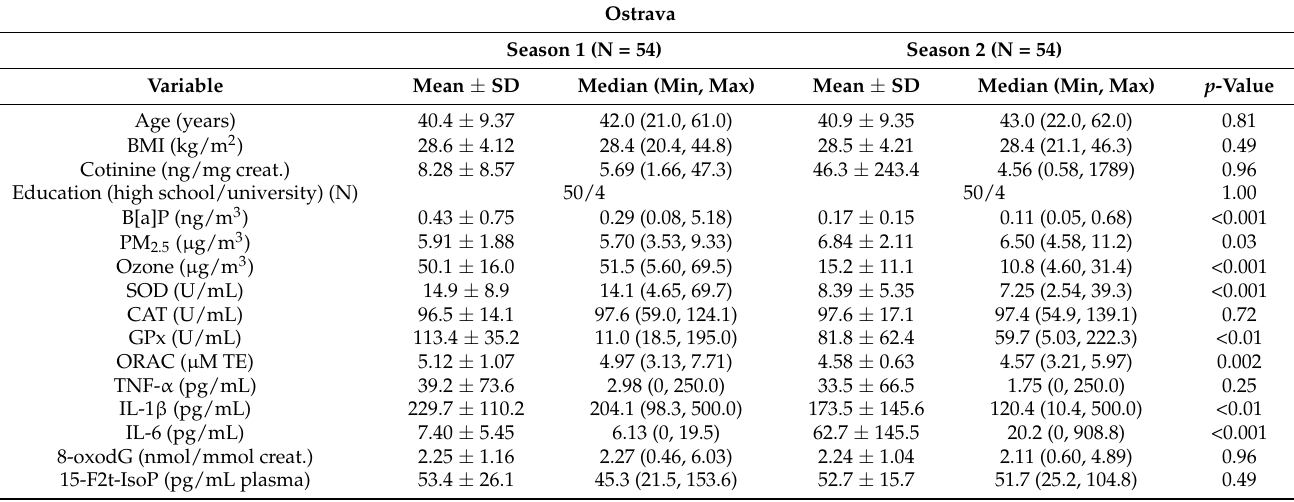
Table 3. Characteristics of the study population, exposure to environmental pollutants, pa- rameters of antioxidant and immune response, and oxidative stress markers: locality Ostrava; SD–standard deviation.